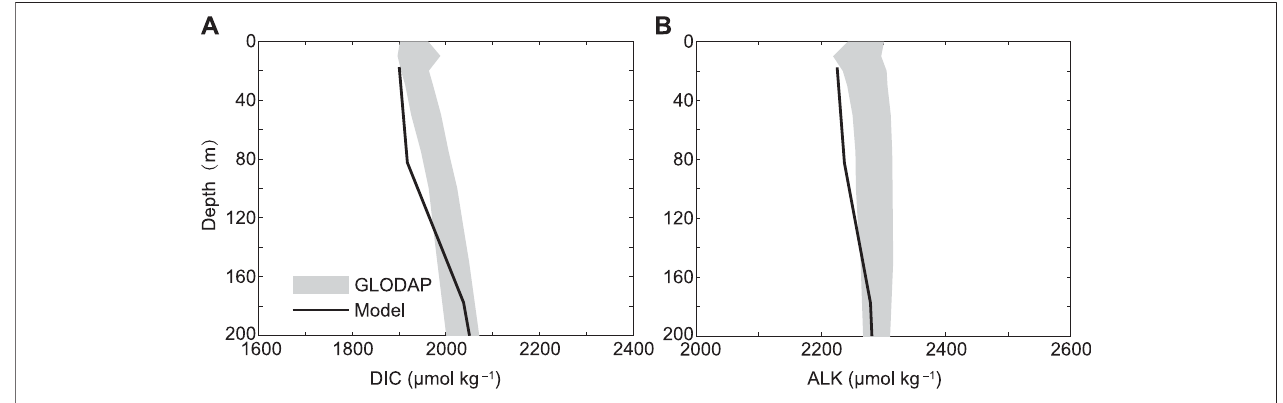
FIGURE 2 | Modeled mean vertical pro fi les for Zhejiang offshore of (A) dissolved inorganic carbon (DIC) and (B) alkalinity (ALK) (1990 – 1999 average) compared with observed estimates from GLODAP data (gray shaded areas denote estimated uncertainties) [41].